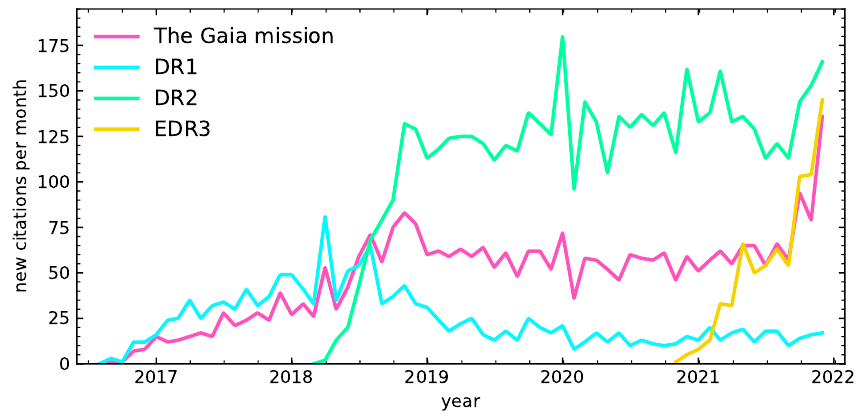
Figure 1. Citations per month for the Gaia mission paper [2] and the papers corresponding to DR1 [3], DR2 [5], and EDR3 [6], up to December